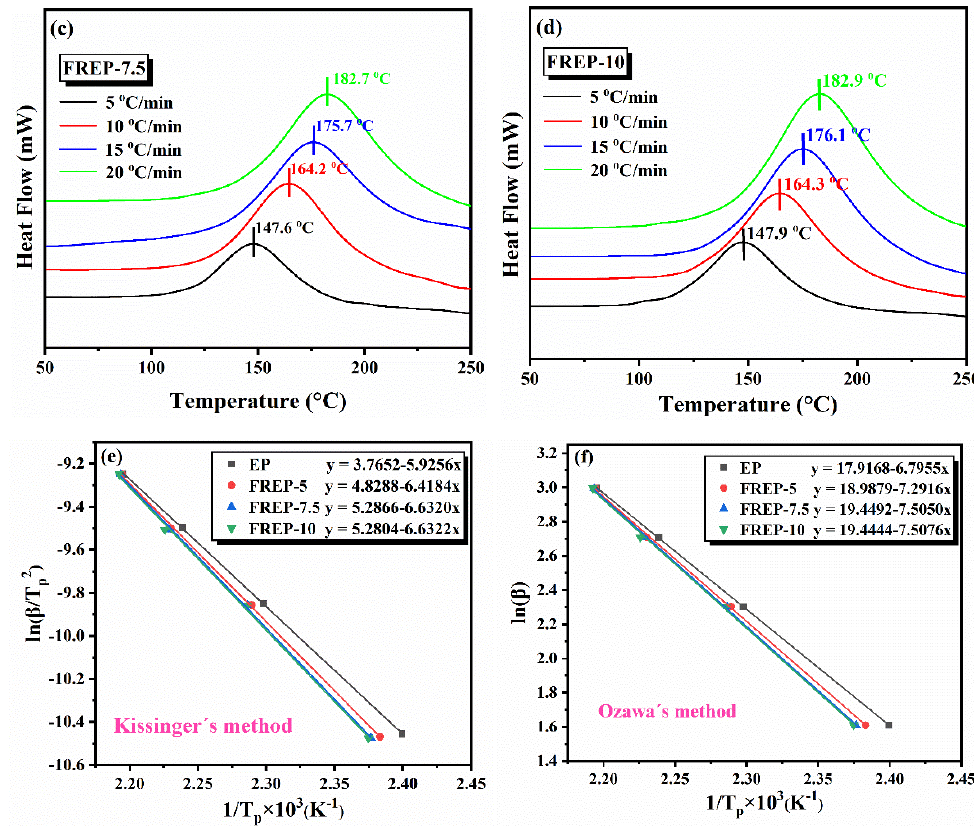
Figure 3. DSC curves of EP ( a ), FREP-5 ( b ), FREP-7.5 ( c ), and FREP-10 ( d ) at different heating rates, fitting curves of Kissinger’s method ( e ) and Ozawa’s method ( f ).